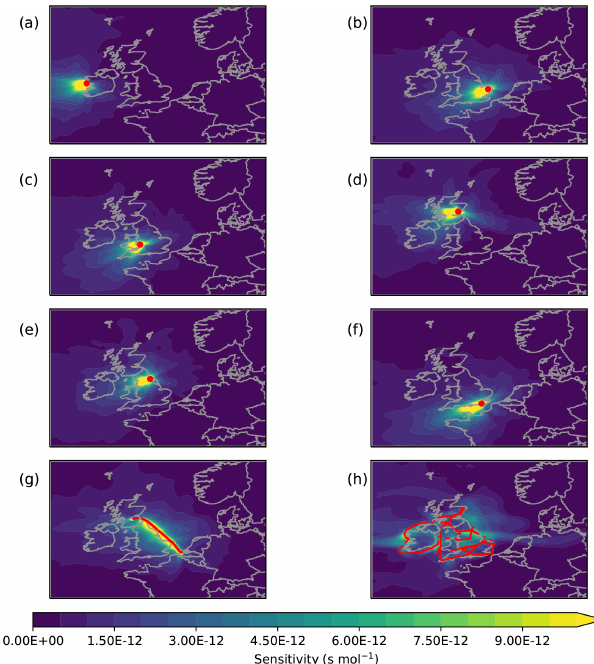
Figure 1. Annual mean NAME footprints for each of the mea- surement sites in 2015, showing the areas the measurements are most sensitive to (the overall NAME domain extended much wider). and (h) FAAM aircraft. Data for the FAAM aircraft (seven flights) are from 2014. Red dots show the measurement locations. The do- main shown covers the spatially varying domain used in the rj- mcmc inversions, which is a subset of the full NAME inversion